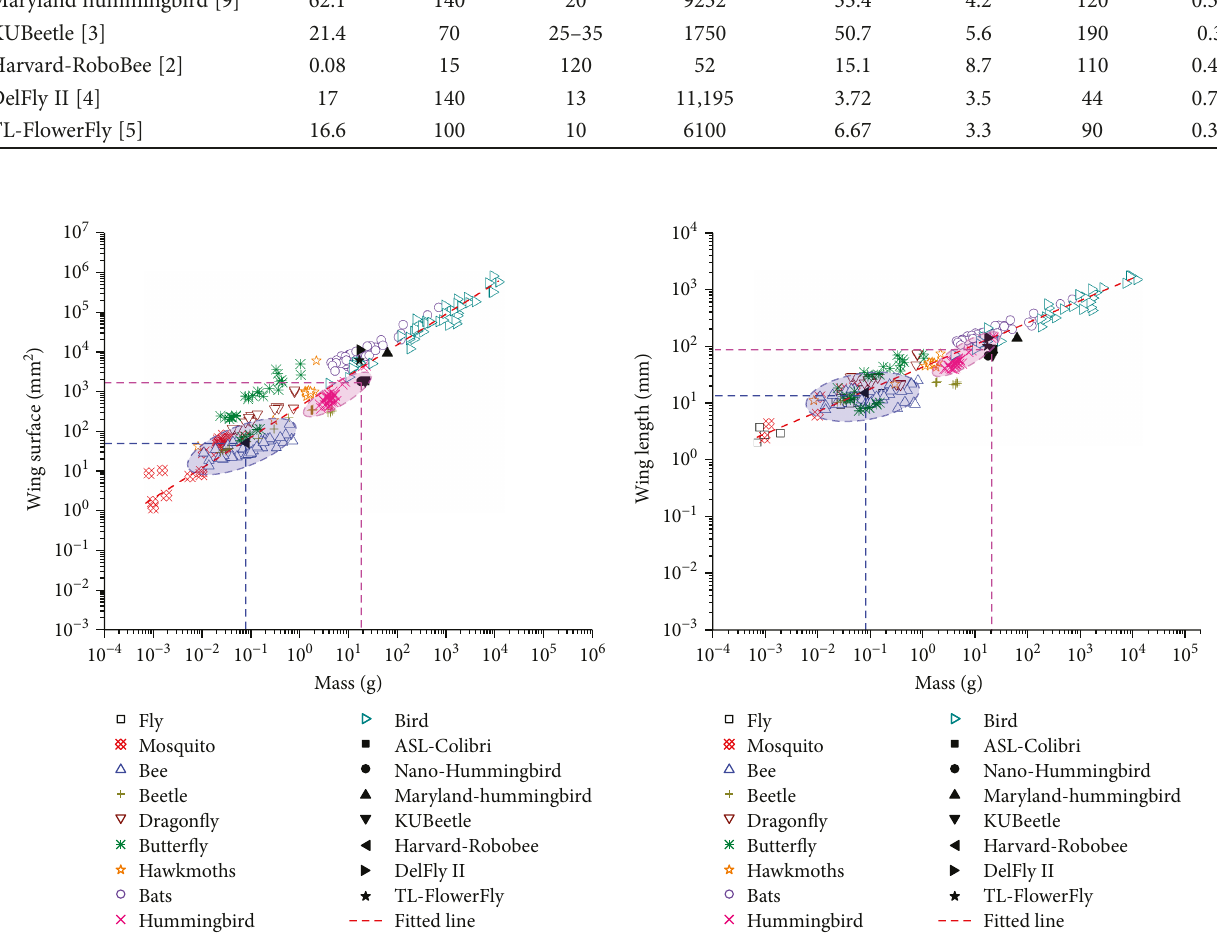
Figure 9: Relation wing surface, wing length vs. mass including the